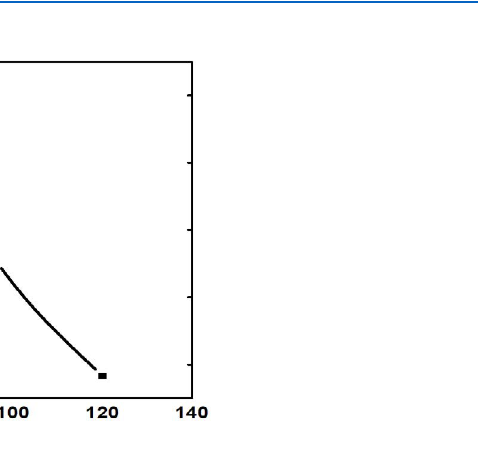
Fig. 1. Maximum b -glucanase enzyme production by bioreactor (it show max. production after 60 h) table 1. Effect of different treatments on sugar beet root rots disease during growing seasons Treatments